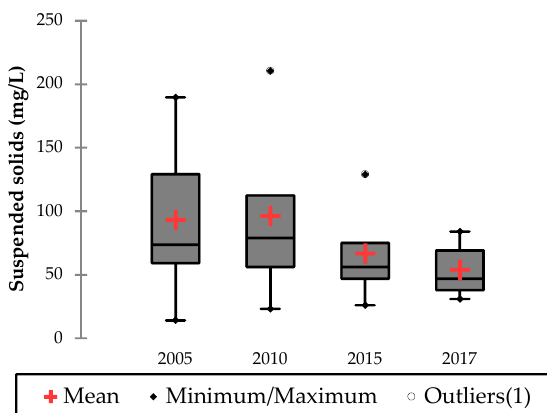
Figure 10. Box plot shows temporal changes in suspended solids in 2005, 2010, 2015, and 2017 at Long Xuyen station, An Giang. Data of suspended solids were obtained from the Southern Regional Hydrometeorological Center in Hochiminh city, Vietnam.